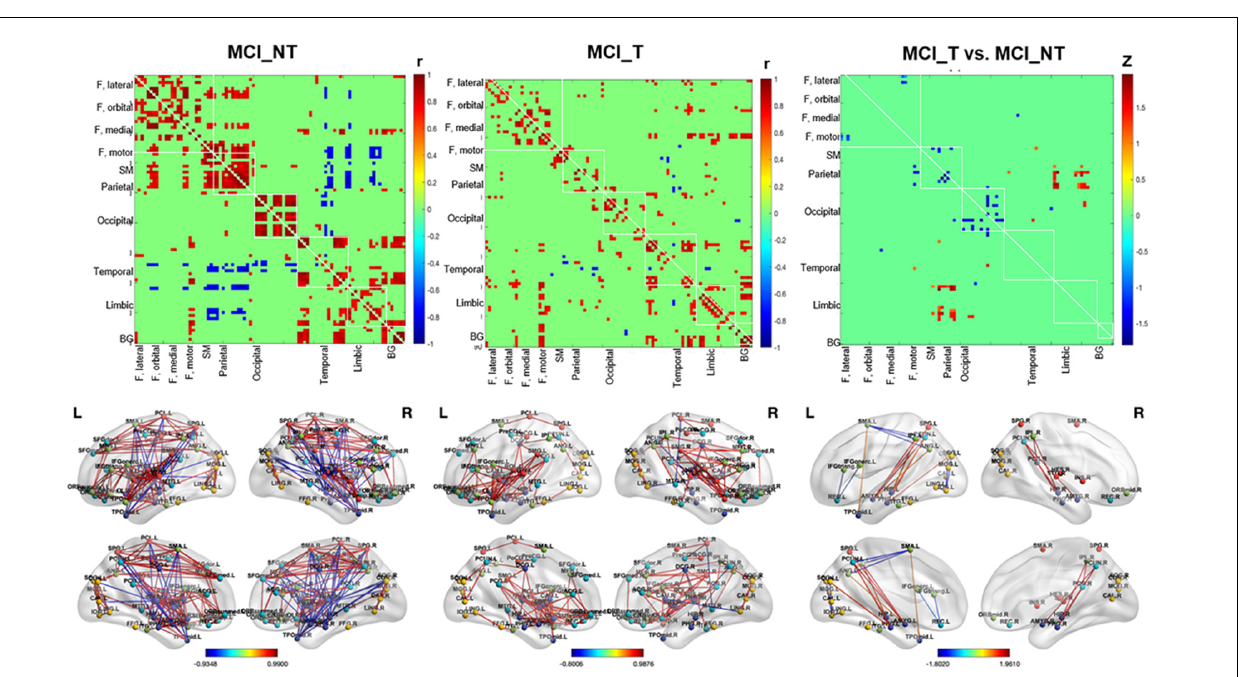
activity across a range of cognitive loads (Shulman et